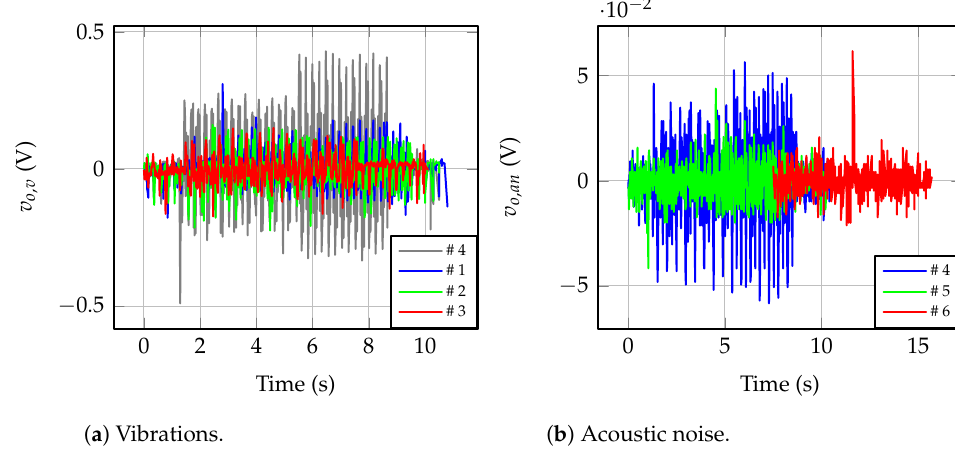
Figure 16. Output voltages for sensor locations in Table 5.